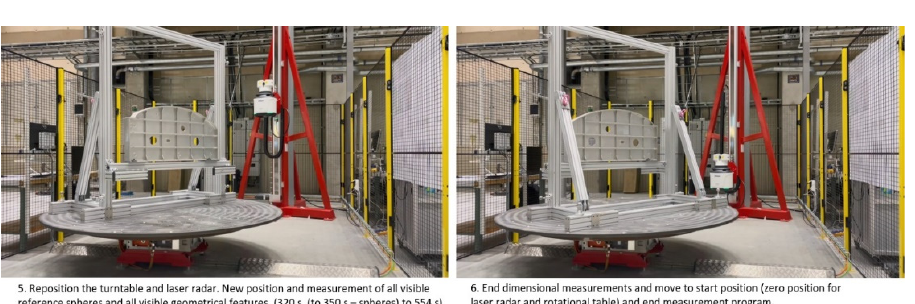
Figure 37. Illustration of the complete measuring cycle and the measuring sequences in the real measuring